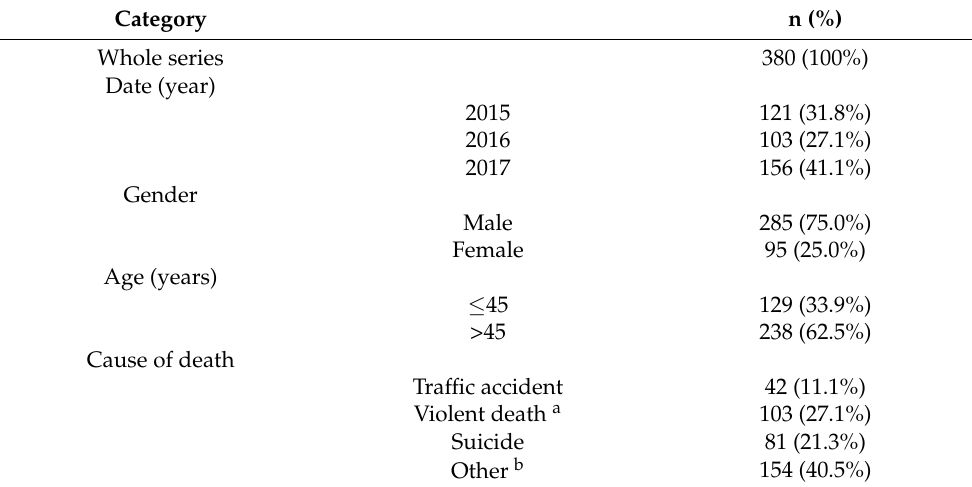
Table 1. Description of subjects by sociodemographic characteristics and forensic data.